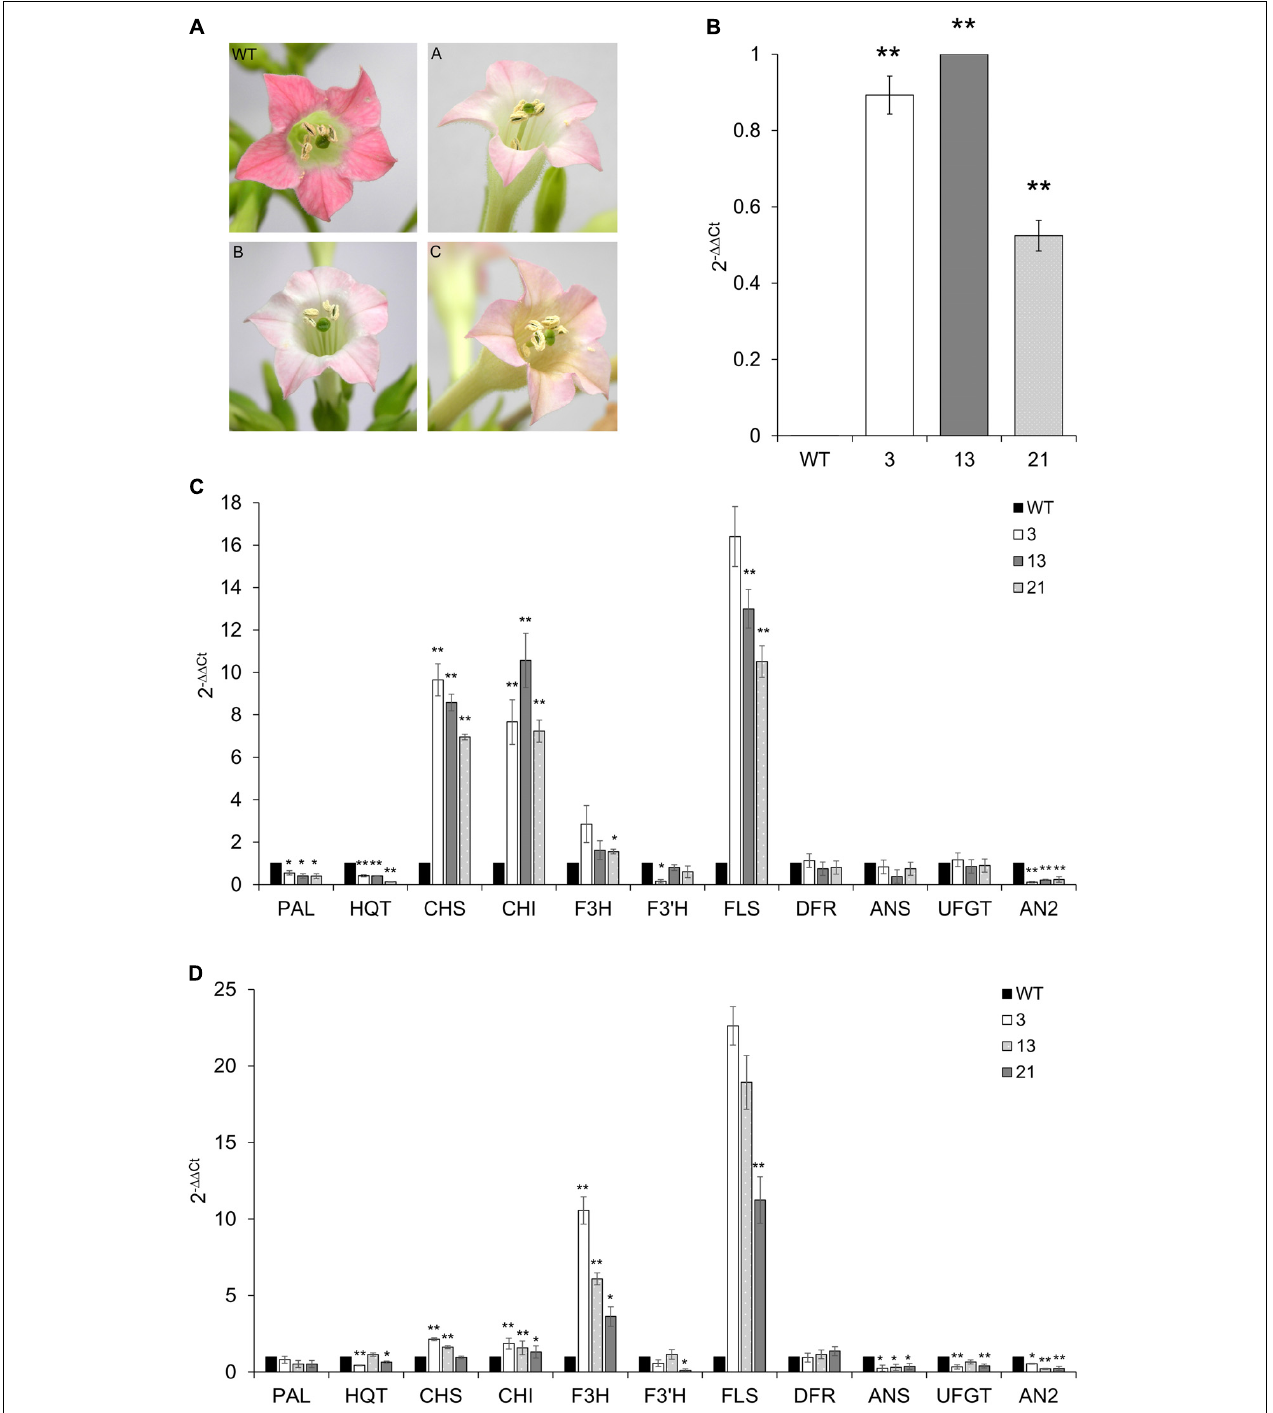
FIGURE 7 | Expression of CcMYB12 transgene and of endogenous phenylpropanoid biosynthetic genes in CcMYB12-expressing tobacco plants. (A) Color of tobacco flowers in transgenic CcMYB12 lines. The pigmentation of corolla limbs of three different transgenic lines expressing CcMYB12 was compared with corolla from WT. (A) line 3, (B) line 21, and (C) line 13. (B) qRT-PCR of exogenous CcMYB12 in transgenic tobacco plants. Line 13 as calibrator. (C,D), Expression levels of the early biosynthetic genes, namely PAL, HQT, CHS, CHI, F3H, F3 (cid:48) H, FLS, and ANS , DFR , UFGT and AN2in transgenic tobacco leaves (C) and flowers (D) . WT as calibrator. qRT-PCR experiments were conducted on cDNAs from various transgenic tobacco T3 plants. Three independent preparations of total RNA from each line were assayed in triplicate. Actin was employed as reference gene. Values are means ± SD of three biological replicates. Asterisks indicate a statistical difference ( ∗ p -value < 0.05; ∗∗ p -value < 0.01) between the means for WT and tested transgenic samples, according to Student’s t -test.